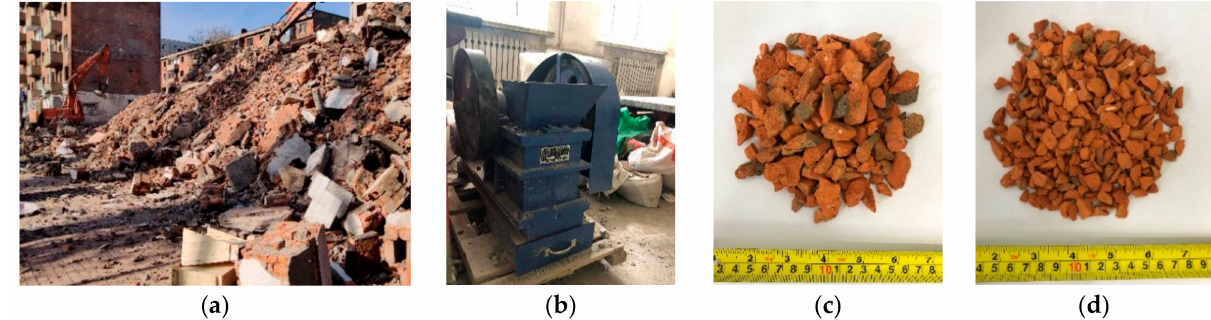
Figure 1. Collecting RBCA: ( a ) construction waste site, ( b ) broken red bricks in the laboratory, ( c ) 10~20 mm particle size, ( d ) 5~10 mm particle size.